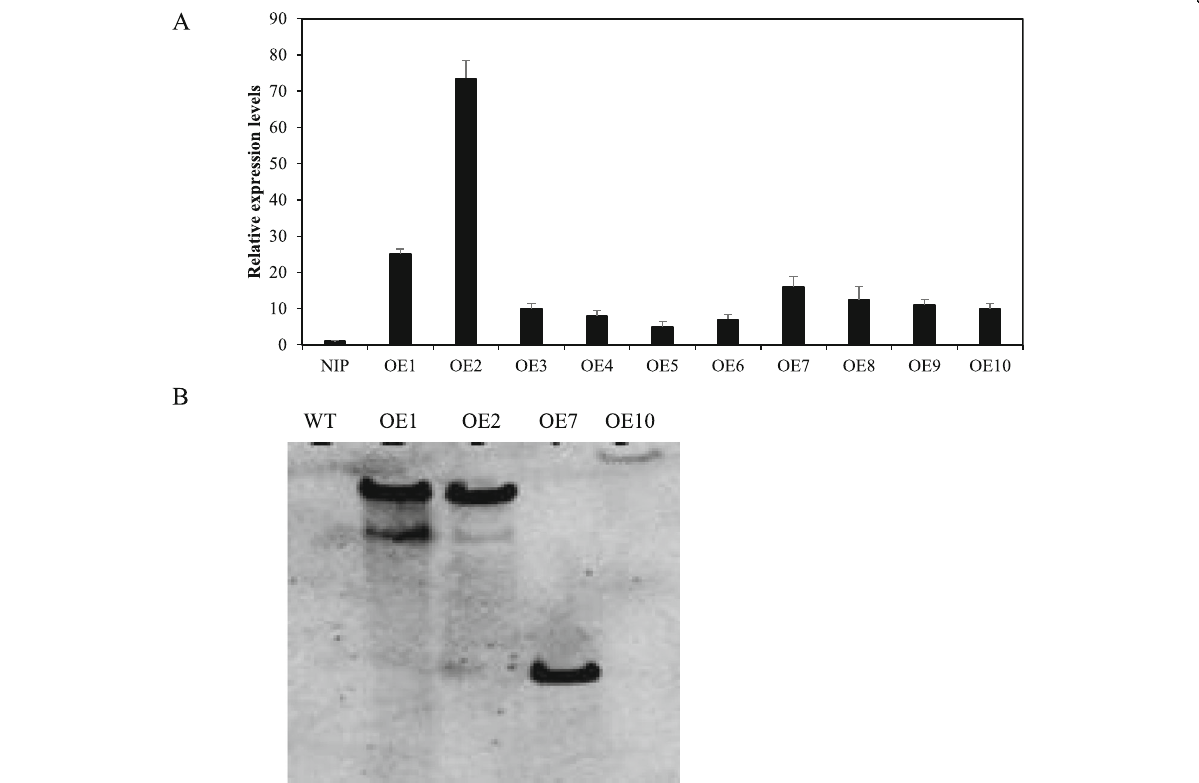
Fig. 4 Identification of transgenic lines overexpressing OsSTAP1. a OsSTAP1 expression analysis in the transgenic lines. Error bars showing the SD are based on three replicates. Actin was used as the endogenous control for normalization of gene expression. b Southern blotting detection of OsSTAP1 in the transgenic rice lines. WT (wild type) as the negative